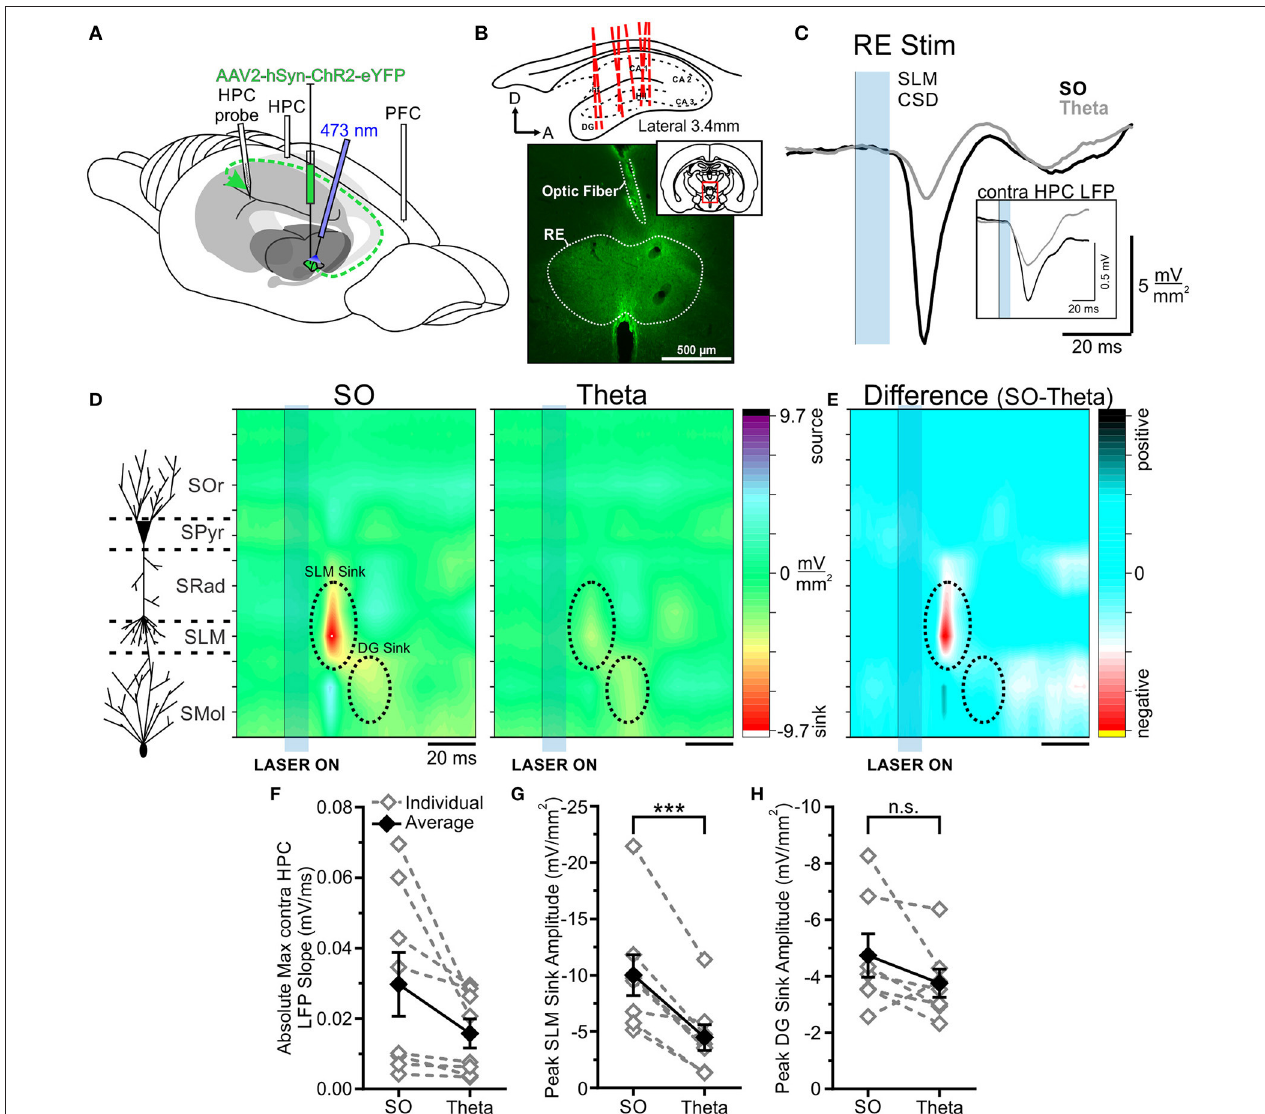
FIGURE 3 | Optogenetic stimulation of RE evokes a much larger response in HPC during SO. (A) Schematic illustration of the recording, injection, and stimulation sites. Schema modified from Amaral and Witter (1995). (B) Top, Schematic sagittal illustration of all multiprobe tracks through HPC. Bottom, Representative coronal tissue section depicting the expression of hSyn-ChR2-EYFP virus localized largely to RE, with optic fiber track positioned dorsal to RE. Inset, Coronal schematic of the relative location (red box) of the image. (C) Current sink/source density traces evoked in stratus lacunosum moleculare (SLM) following optogenetic stimulation (10ms pulse at 473nm wavelength; blue rectangle) of RE during SO (black line) and theta (gray line), averaged over 64 trials. Stimulation of RE during SO produces a much larger current sink in HPC than does stimulation during theta. Inset, Local field potentials recorded from the contralateral HPC following the same optogenetic stimulation of RE during SO (black line) and theta (gray line), showing a larger response during SO. (D) Left, Schematic depiction of HPC cell lamina as determined by theta profile. Color contour plot of current source density (CSD) values just before and following 10ms optogenetic stimulation of RE (black line and blue rectangle) during SO (middle) and during theta (right). RE stimulation produces a large current sink centered around SLM (with a corresponding current source in DG) which is of much greater magnitude during SO compared to during theta. A later DG sink is also evoked by RE stimulation, which does not significantly differ in amplitude between states. CSD scales for both contour plots are identical, from − 9.7 to 9.7 mV/mm 2 . (E) Difference contour plot created by subtracting the theta CSD [ (D) , right] from the SO CSD [ (D) , middle] in the same animal, illustrating that the difference between the two states is largely confined to the SLM sink. The scale of difference contour plot is − 6.4–6.4 mV/mm 2 . (F) Absolute value of the maximum local field potential slope evoked in contralateral HPC following optogenetic stimulation of RE averaged over 32–64 trials, for individual rats (gray, hollow diamonds, and dashed gray lines) and on average (black, filled diamonds, and solid black line). Stimulation during SO evokes a slope of greater magnitude than stimulation during theta in every case, although this difference is not significant overall ( p = 0.057). (G) Peak SLM sink amplitude evoked by optogenetic stimulation of RE during SO and theta in the same individual animals (gray, hollow diamonds, and dashed gray lines) and on average (black, filled diamonds, and solid black line). A significantly larger sink at SLM is evoked during SO than during theta. (H) Peak DG sink amplitude evoked by optogenetic RE stimulation across both states, in individuals (gray, hollow diamonds, and dashed gray lines) and on average (black, filled diamonds, and solid black line), showing no significant difference across states. Error bars represent SEM. *** p < 0.001. SOr, Stratum oriens; SPyr, stratum pyramidale; SRad, stratum radiatum; SLM, stratum lacunosum-moleculare; SMol, stratum moleculare.